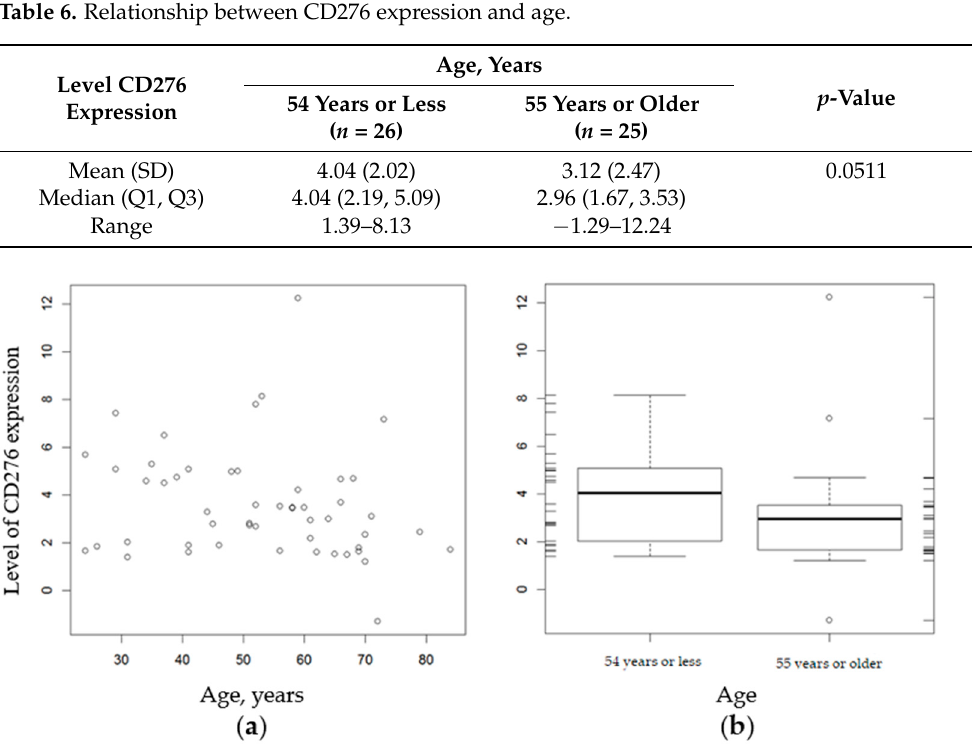
Figure 3. Relationship between CD276 expression by tumor cells and age, years ( a ); range of age ( b ).